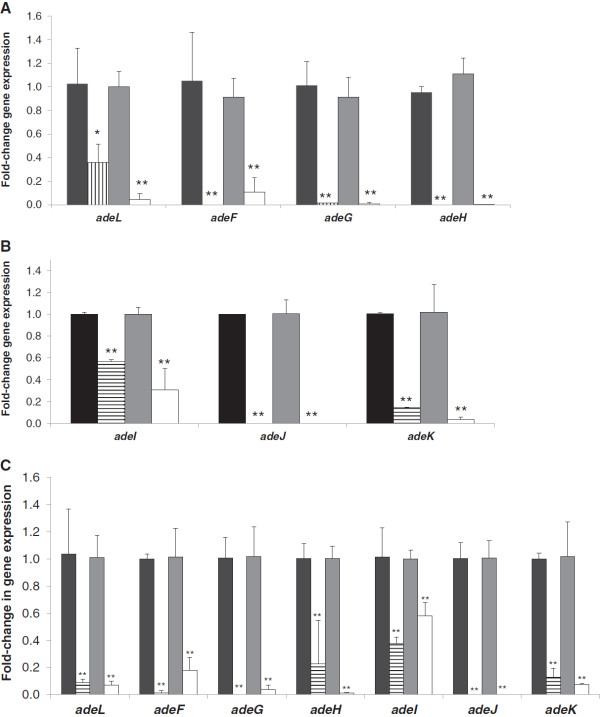
Comparison of adeL-adeFGH operon and adeIJK operon expression in DB and R2 deletion mutants and parental strains. Panel A, Fold-change in adeL, adeF, adeG and adeH expression in DB versus DBΔadeFGH, R2 versus R2ΔadeFGH; Black bars, DB; grey bars, R2; vertical stripes, DBΔadeFGH; white bars, R2ΔadeFGH. Panel B, Fold-change in adeI, adeJ and adeK expression in DB versus DBΔadeIJK, and R2 versus R2ΔadeIJK; Black bars, DB; grey bars, R2; horizontal stripes, DBΔadeIJK; white bars, R2ΔadeIJK. Panel C, Fold-change in adeL, adeF, adeG, adeH, adeI, adeJ and adeK expression in DB versus DBΔadeFGHΔadeIJK, and R2 versus R2ΔadeFGHΔadeIJK. Black bars, DB; grey bars, R2; horizontal stripes, DBΔadeFGHΔadeIJK; white bars, R2ΔadeFGHΔadeIJK. All differences in fold-change in gene expression between the parental strains and deletion mutants were significant (*, p < 0.05; **, p < 0.01).